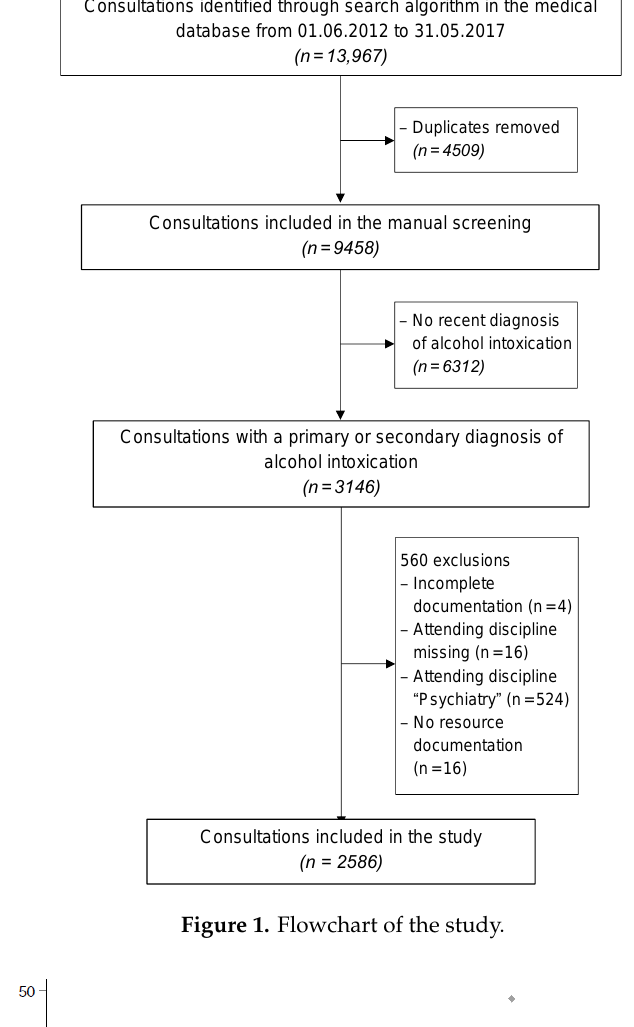
Figure 1. Flowchart of the study. Int. J. Environ. Res. Public Health 2020 , 17 , x FOR PEER REVIEW